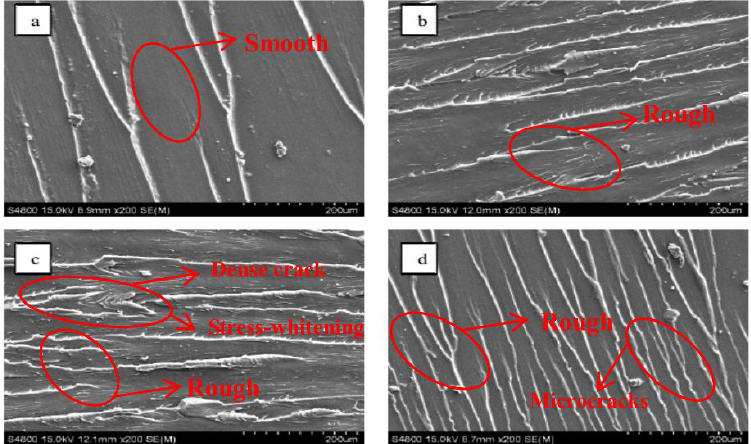
Figure 12. SEM images of the impacted fracture surfaces of SMEP specimens with different GO contents of ( a ) 0 wt %, ( b ) 0.4 wt %, ( c ) 0.8 wt % and ( d ) 1.2 wt % after impact test.